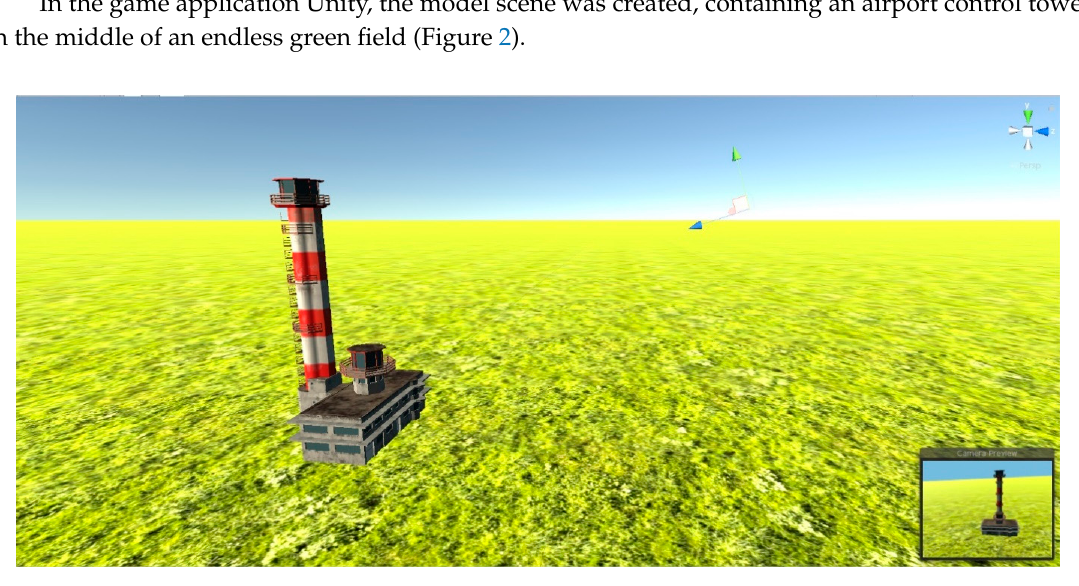
Figure 2. Unity model scene, containing an airport control tower in the middle of an endless green field.